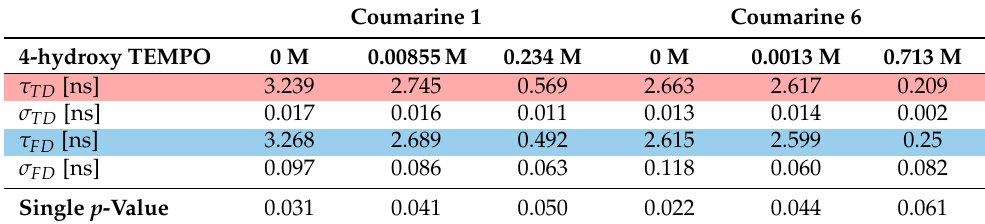
Table 7. Results for the quenching experiments for coumarine 1 and coumarine